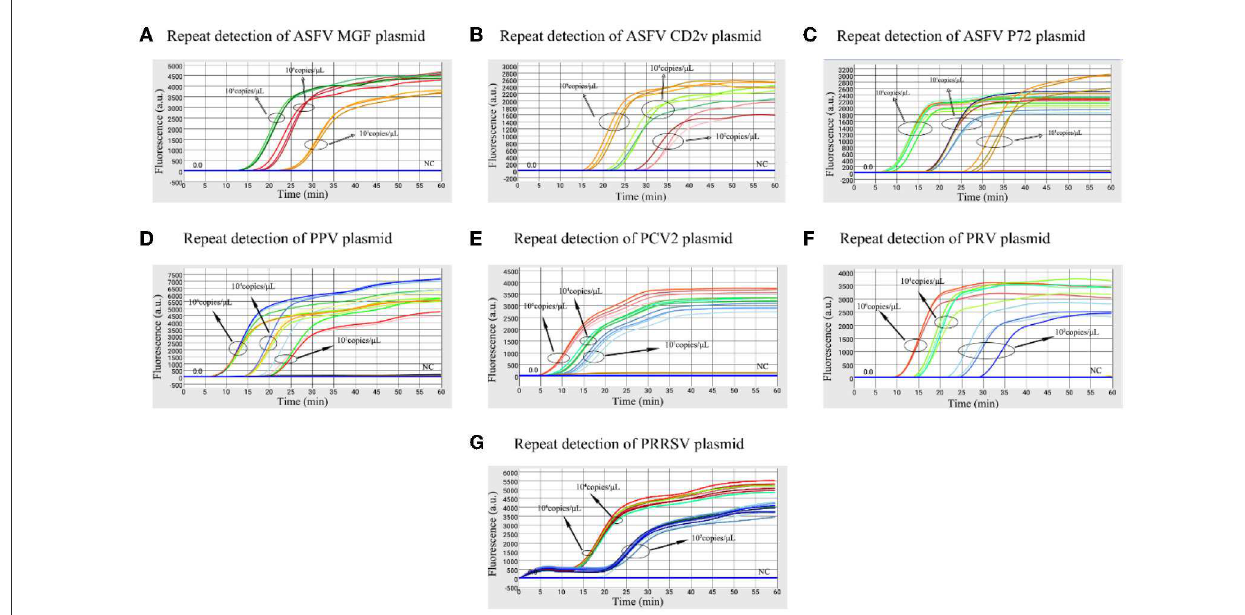
FIGURE5 Stability test of the microfluidic-LAMP chip detection system for five swine pathogens. (A–G) All tests were performed using high, medium and low (detection limits) concentration standard plasmids.